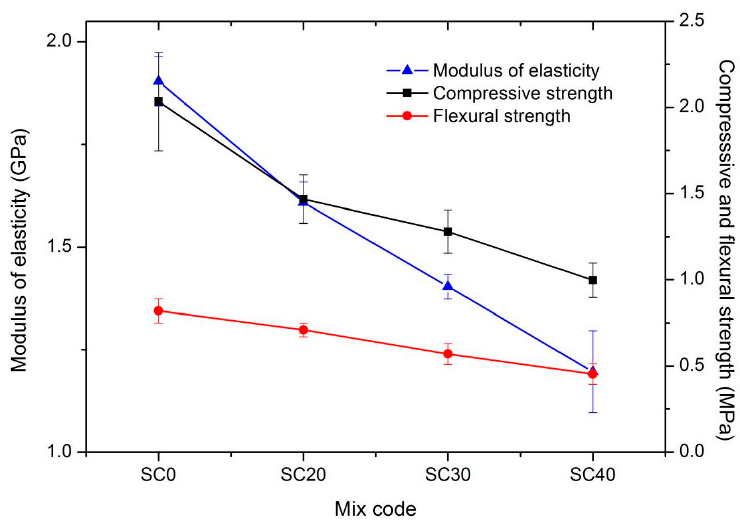
Figure 5. Mechanical properties of series II mixtures.